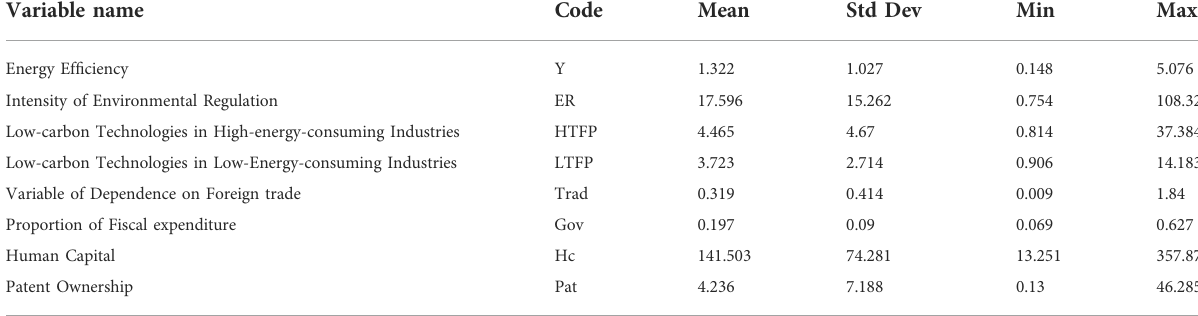
TABLE 2 Descriptive statistics of variables.